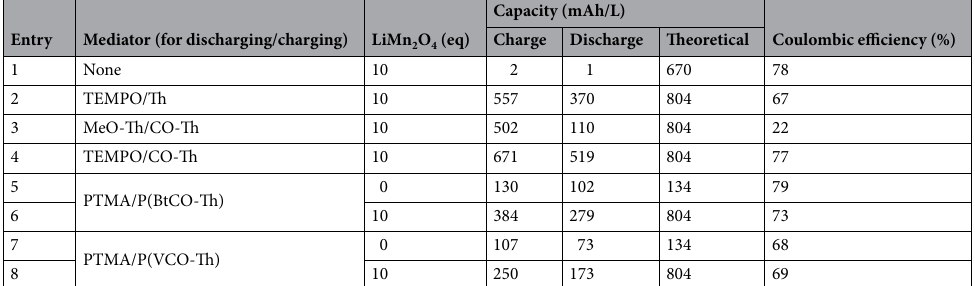
Table 1. Charge/discharge results for the H-type